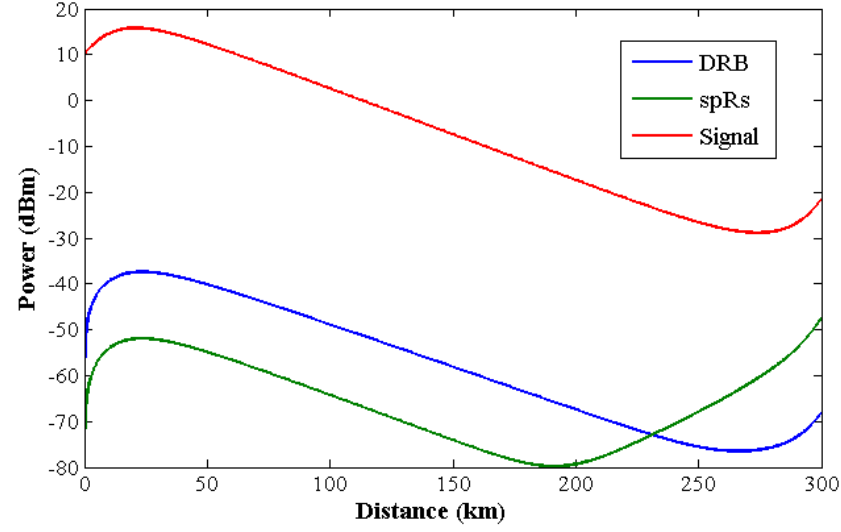
Figure 6. Power profiles of the signal, spontaneous Raman scattering (spRs), and DRB.